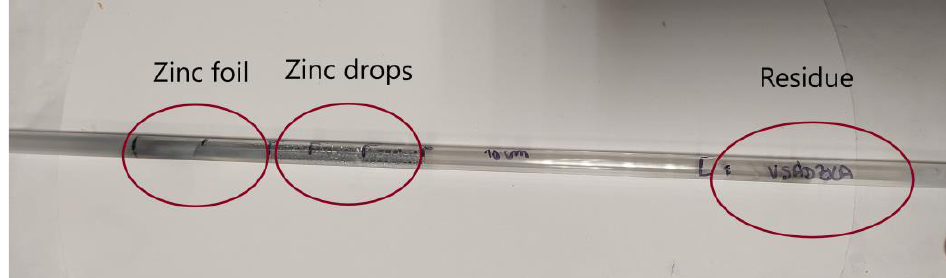
Figure 7. Quartz tube with a dose after evaporation process: zinc foil, zinc drops, and the residue.